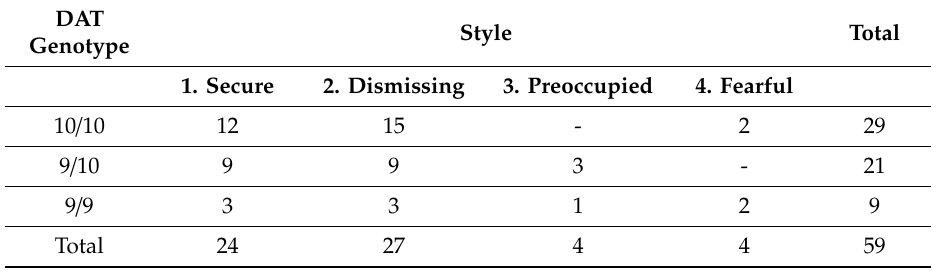
Table 2. Contingency matrix for people in the sample below the impulsivity threshold. DAT Genotype